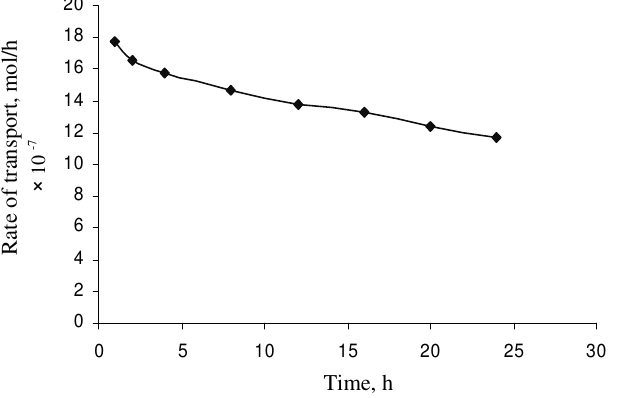
Figure 4 . The effect of time on the rate of competitive transport of Cu(II).